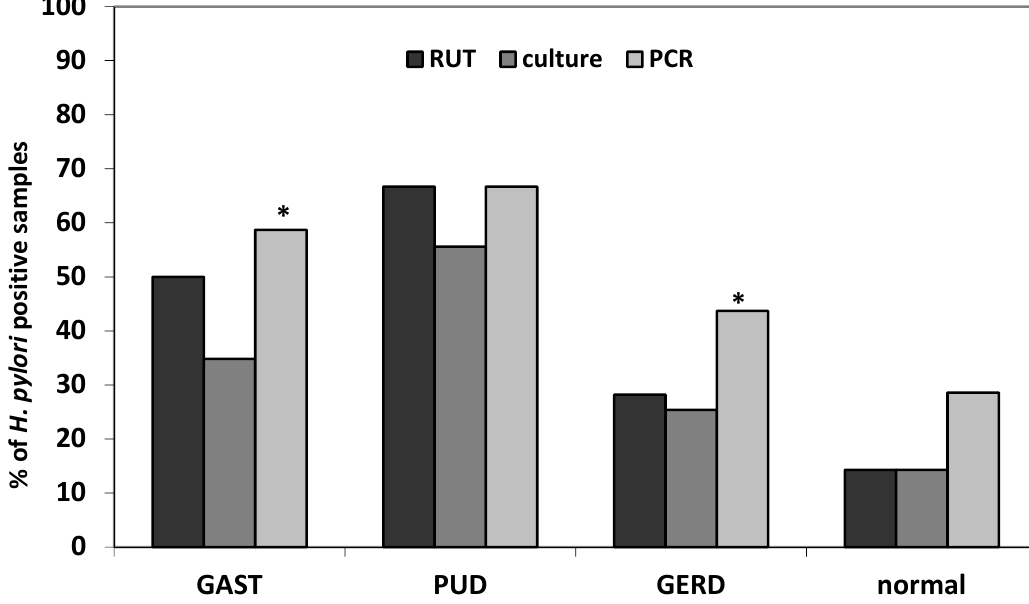
Figure 1. H. pylori identification using different methods regarding clinical diagnosis (GAST, gastritis/duodenitis; PUD, peptic ulcer disease (gastric/duodenal); GERD, gastroesophageal reflux disease); * p < 0.05 (PCR vs. culture).